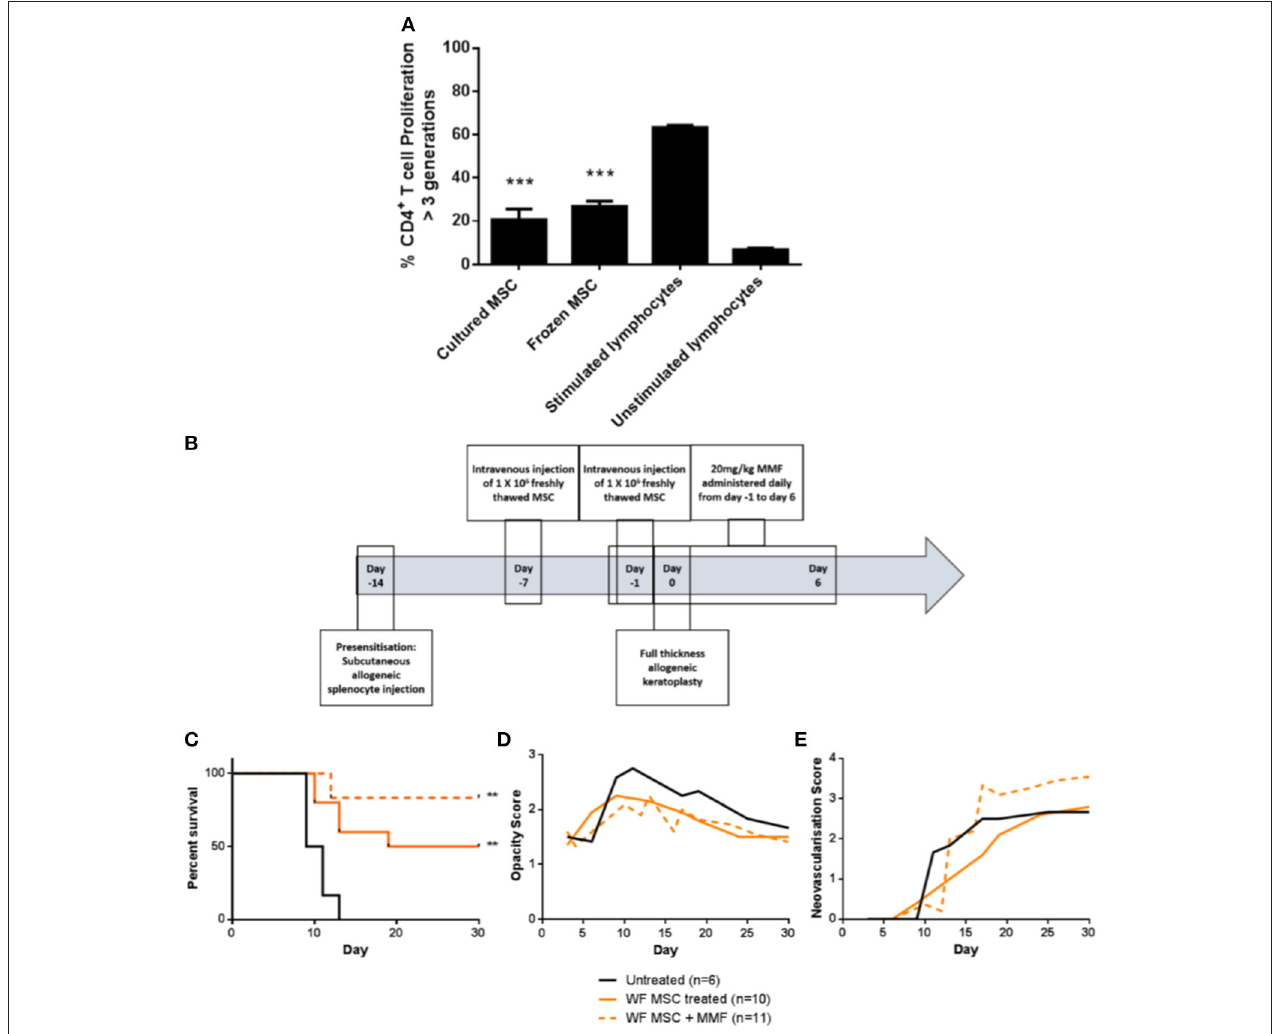
FIGURE 7 | Cryopreserved third party allo-MSC are immunosuppressive and capable of prolonging corneal allograft survival without and with mycophenolate mofetil co-administration in pre-sensitized recipients. (A) Graph of CD4 + T-cell proliferation, quantified by flow cytometry-based fluorescent dye dilution as the proportion of cells that had proliferated through > 3 generations, in 4-day cultures of Lewis rat splenocytes under four conditions: Anti-CD3/CD28 stimulation + freshly cultured Wistar Furth MSC (Cultured MSC); Anti-CD3/CD28 stimulation + thawed, cryopreserved Wistar Furth MSC (Frozen MSC); Anti-CD3/CD28 stimulation alone (Stimulated lymphocytes) and No stimulation (Unstimulated lymphocytes). (B) Schematic representation of administration of thawed, cryopreserved (freshly thawed) third-party allo-MSC and MMF in the pre-sensitized high-risk rat corneal transplant model. (C) Kaplan-Meier curves demonstrating rejection-free survival of pre-sensitized Lewis recipients of DA corneas that received no treatment (Untreated, n = 6); thawed, cryopreserved third-party allo-MSC (WF MSC, n = 10) and thawed, cryopreserved third-party allo-MSC with MMF (WF MSC + MMF, n = 11). (D,E) Trend-lines for corneal allograft opacity scores (D) and neovascularisation scores (E) of the same three groups of pre-sensitized corneal transplant recipients up to day 30 post-transplant. Statistical significance was determined using a Log-rank (Mantel-Cox) test, ** p < 0.01 compared to Untreated group. *** p <